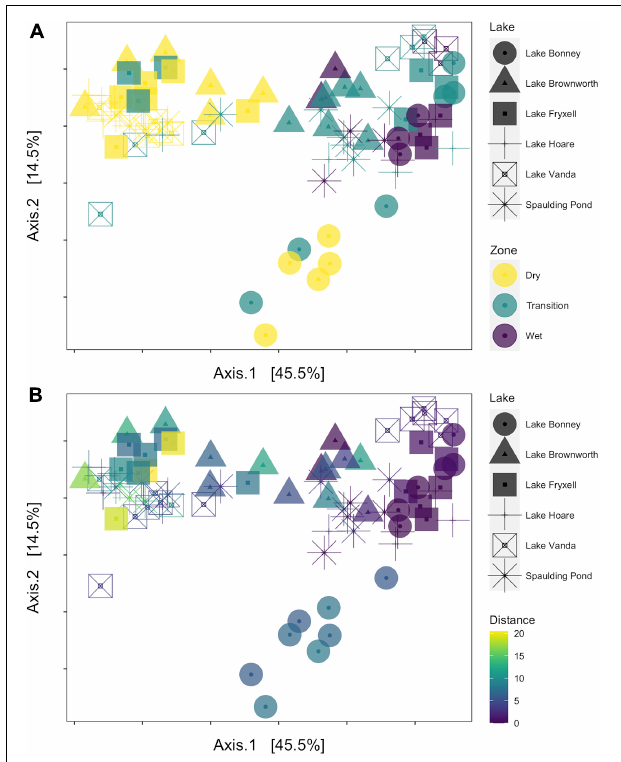
FIGURE 4 | Principal coordinate analysis (PCoA) of microbial community compositional data based on a weighted UniFrac distance matrix. (A) The samples are colored by transect zone. (B) The samples are colored according to their distance from the lake shore. Chloroflexi, Deinococcota, Verrucomicrobiota,